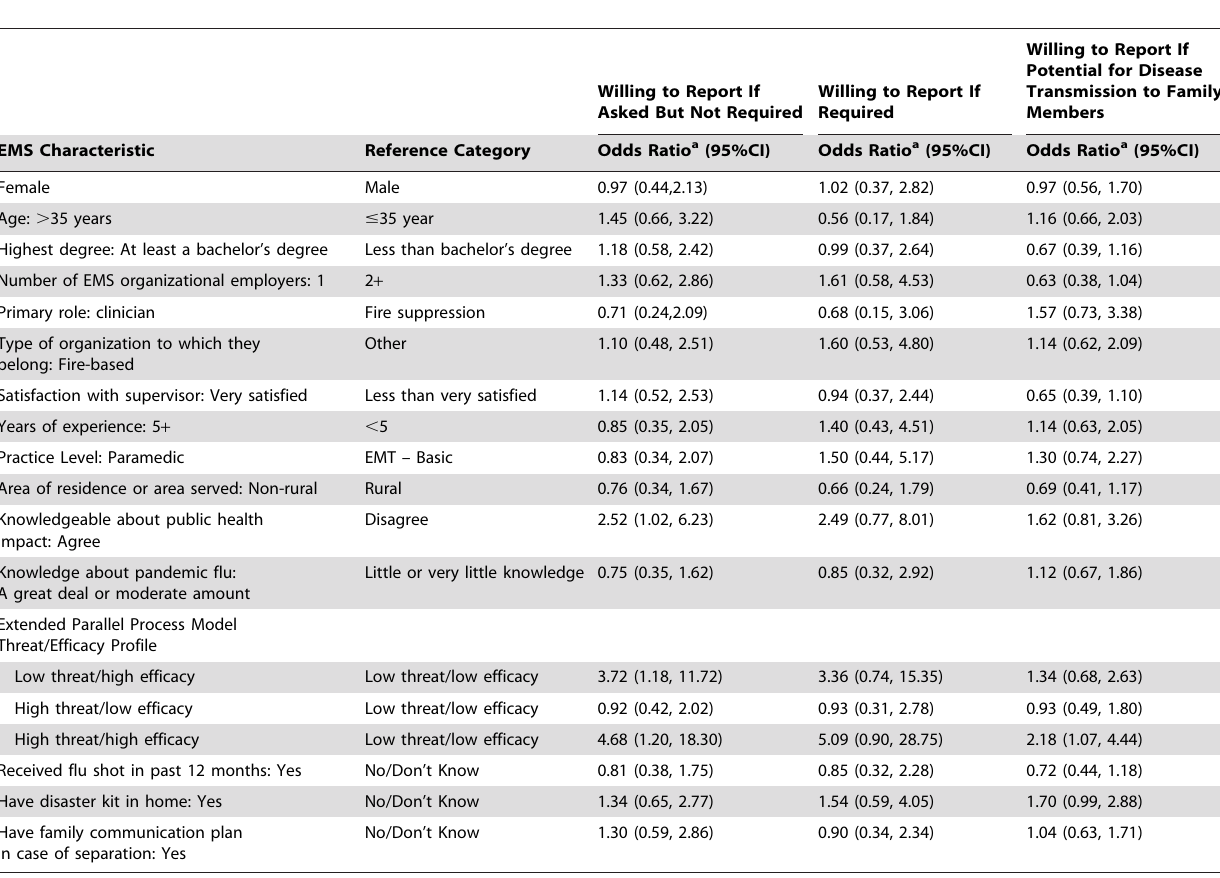
Table 3. Weighted multivariate logistic regression analyses to evaluate the associations between willingness-to-report scenarios and EMS characteristics regarding a pandemic influenza emergency (adjusted for all